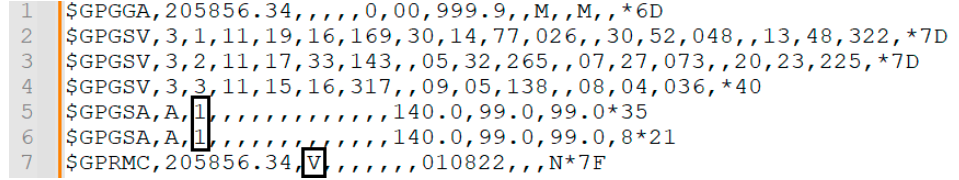
Figure A3. Example of incorrect information in a database.